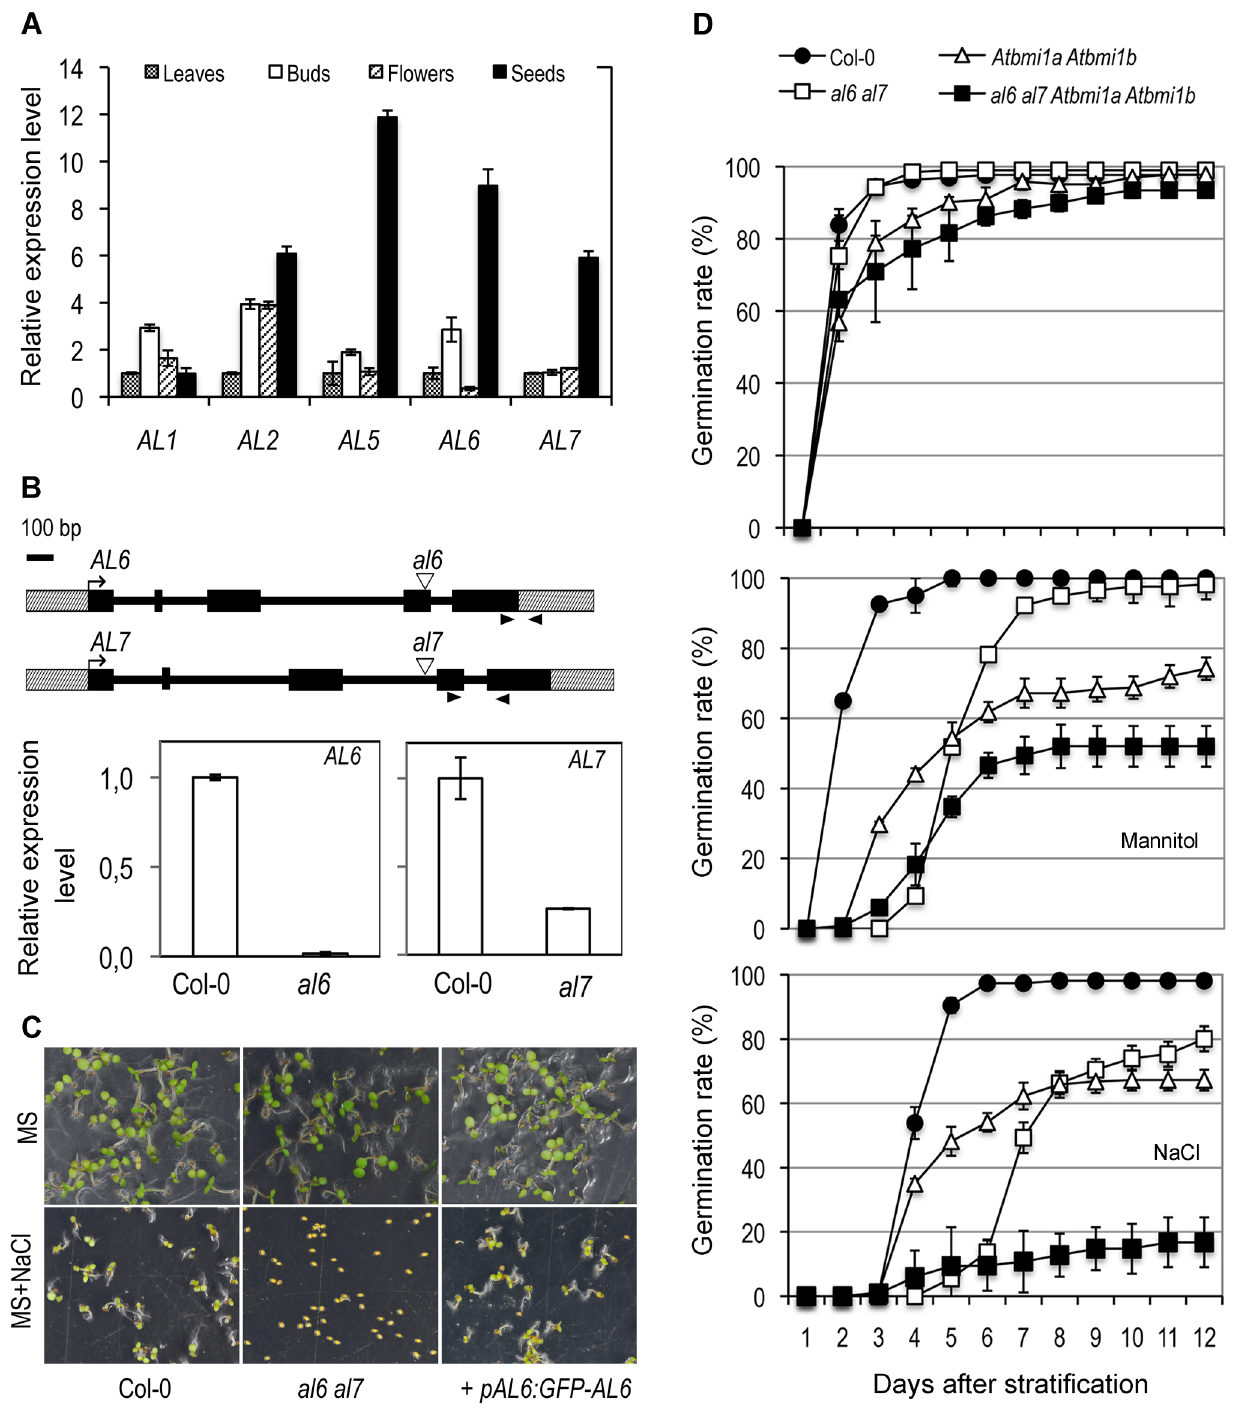
Figure 3. Functional characterization of AL genes. (A) Tissue-specificity of AL gene expression. Relative expression levels of AL1 , AL2 , AL5 , AL6 , and AL7 were determined by quantitative RT-PCR in different plant organs. Leaves: rosette leaves from 4-week-old plants; Buds: floral buds before anthesis; Flowers: flowers at anthesis; Seeds: dry seeds. Data represent means 6 SD of three biological replicates. (B) AL6 and AL7 genomic structure and T-DNA insertion mutants. Genes are schematically represented by black boxes for exons, black lines for introns and dashed boxes for untranslated regions. Triangles indicate T-DNA insertion sites and arrowheads indicate RT-PCR primer positions. Relative expression levels of AL6 and AL7 in Col-0 and in al6 and al7 mutants are shown as means 6 SD of three biological replicates. (C) Representative seed germination images of Col-0, al6 al7 double mutant, and the double mutant complemented by the AL6 promoter driving GFP-AL6 fusion gene ( + pAL6:GFP-AL6 ). Images were taken five days after stratification from plates containing MS media or MS supplemented with 100 mM NaCl (MS + NaCl). (D) Germination rate of Col-0, double mutants al6 al7 and Atbmi1a Atbmi1b , and the quadruple mutant al6 al7 Atbmi1a Atbmi1b plated on MS (top graph), MS supplemented with 200 mM mannitol (middle graph) or with 100 mM NaCl (bottom graph). Data represent average germination percentages 6 SD of three biological replicates, each . 60 seeds, observed daily for 12 days after stratification. doi:10.1371/journal.pgen.1004091.g003 PLOS Genetics | www.plosgenetics.org 5 January 2014 | Volume 10 | Issue 1 |